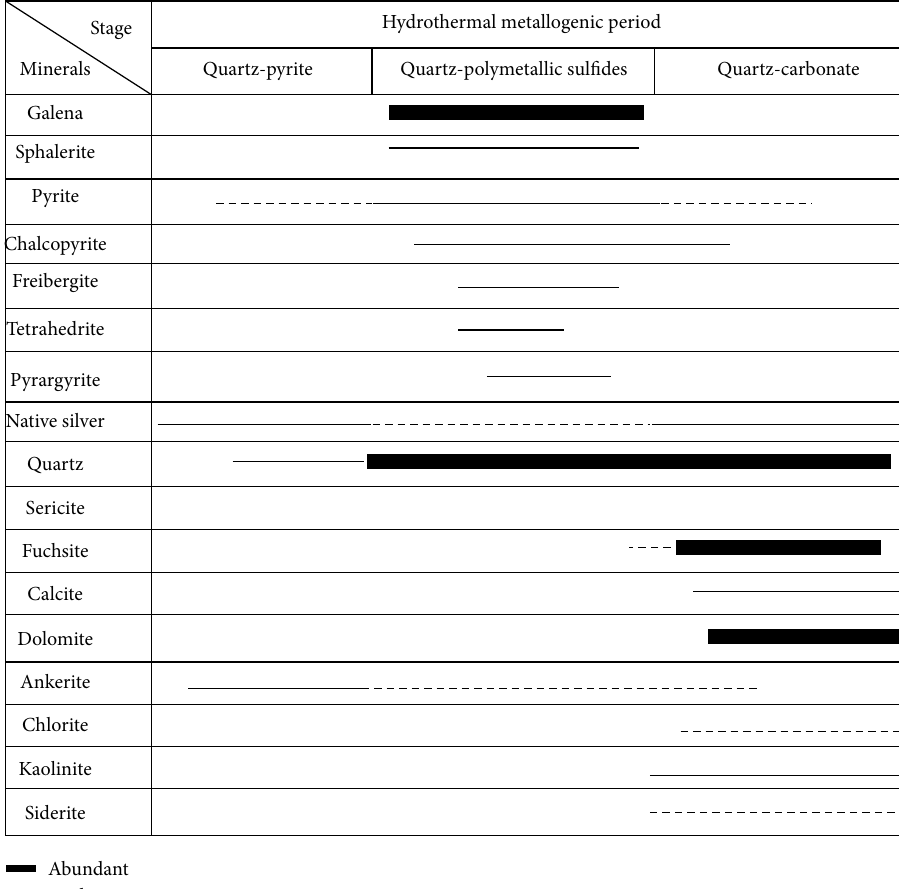
Figure 6: Paragenetic sequence of ore and gangue minerals at the Longmendian